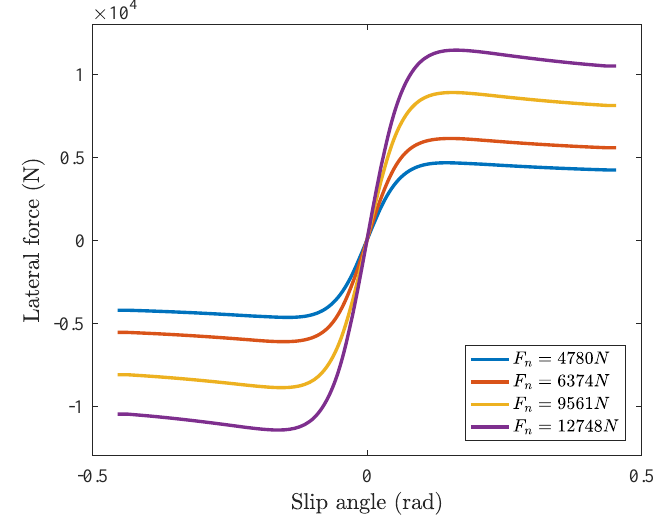
Figure 5. The lateral forces with different vertical forces F n